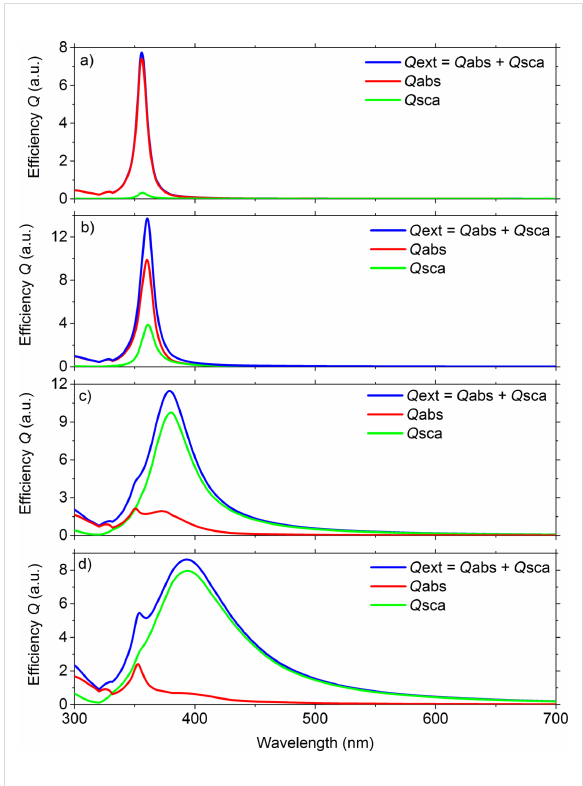
Figure 10: Calculated scattering efficiencies (absorption, scattering and extinction) in air obtained from Mie theory for a single silver nano- particle with a diameter of: (a) 20 nm, (b) 40 nm, (c) 60 nm and (d) 100 nm.